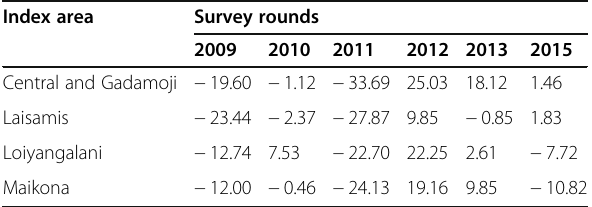
Table 1 Standardized normalized difference vegetation indices during survey